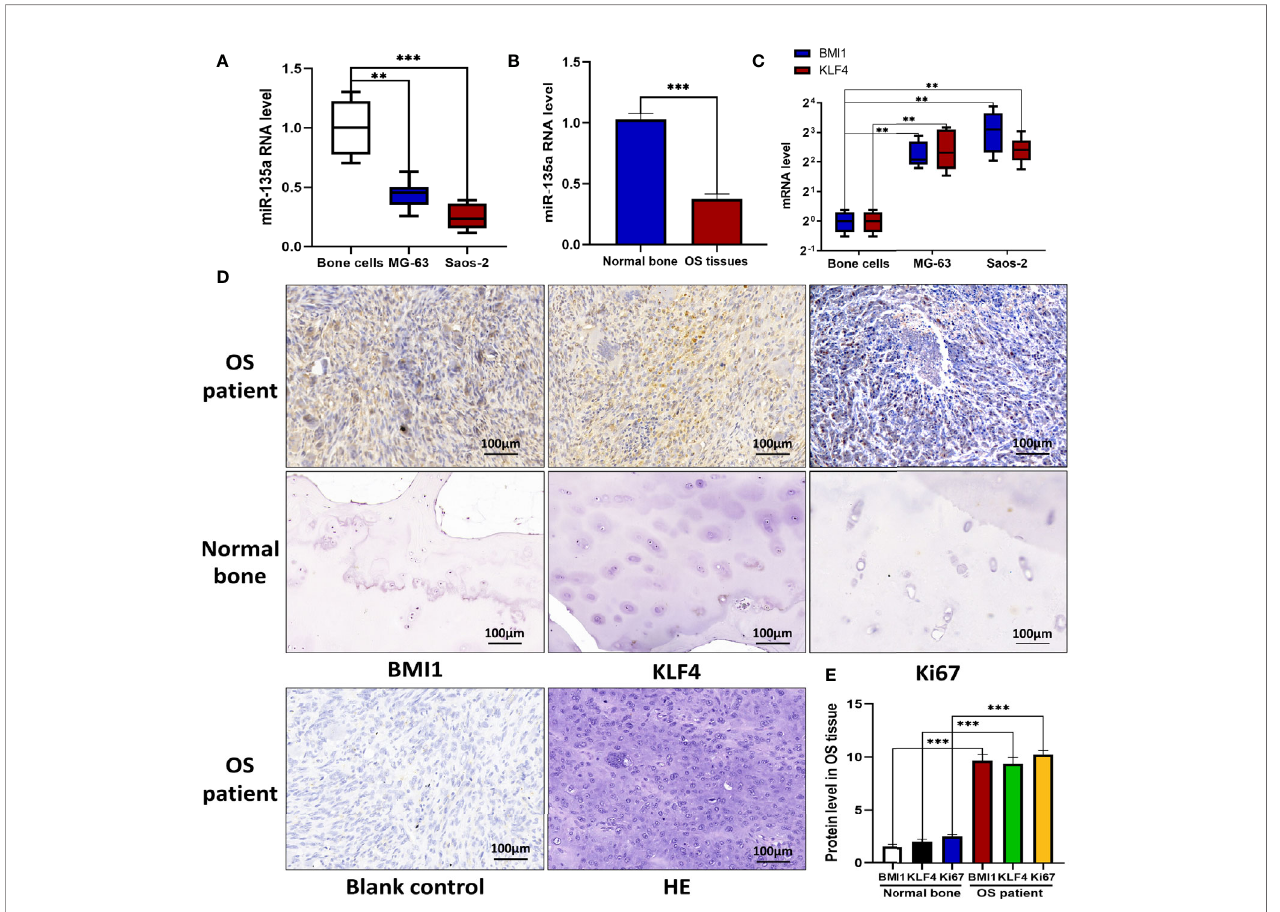
FIGURE 1 | Downregulation of miR-135a and upregulation of BMI1 and KLF4 in OS cell lines and tissues. (A) RT-qPCR. OS cell lines Saos-2 and MG-63, and primary normal bone cells (osteoblasts) were grown and then subjected to RT-qPCR analysis. The results showed that endogenous miR-135a expression was decreased in Saos-2 and MG63 cells when compared to osteoblasts (** p < 0.01; *** p < 0.001; n=3). (B) RT-qPCR. Levels of endogenous miR-135a expression was decreased in OS tissues when compared to normal bone (*** p < 0.001; n=3). (C) RT-qPCR. Levels of BMI1 and KLF4 mRNA were higher in Saos-2 and MG63 cell lines compared with osteoblasts (** p < 0.01; n=3). (D) Immunohistochemistry. Human OS and normal bone tissues were collected and subjected to immunohistochemical analysis. Scale bar, 100 m m. (E) The graph represents quanti fi ed data of the immunohistochemistry (*** p < 0.001; n = 10). All the data from qPCR were expressed as the mean ±